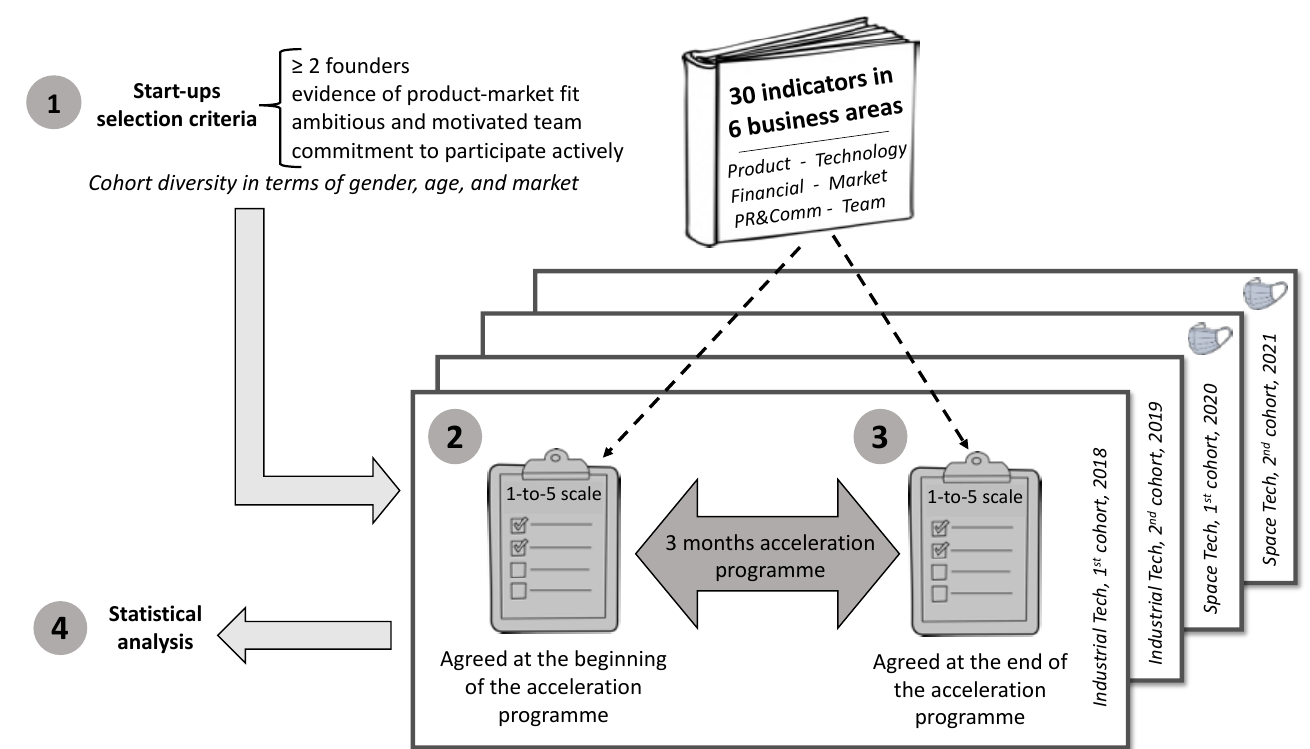
Figure 1. Graphical representation of the research methodology.